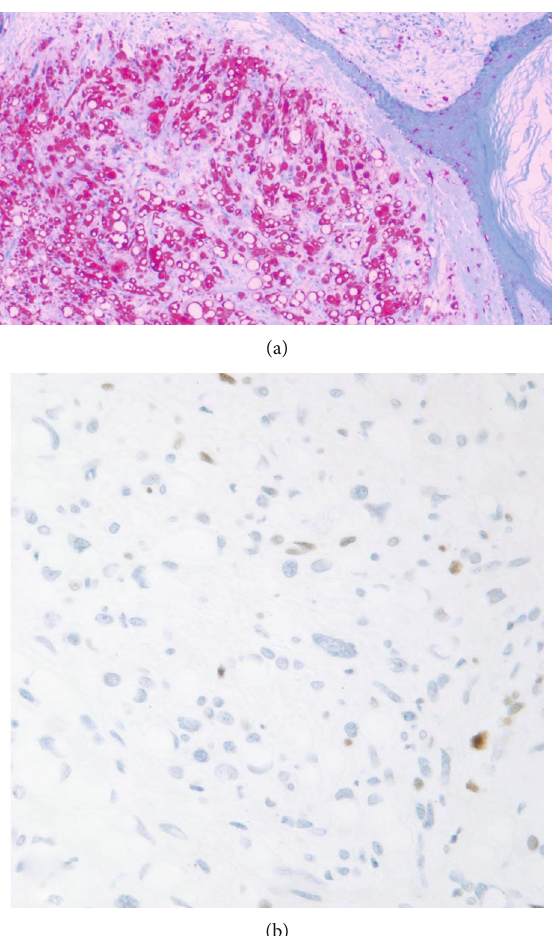
Figure 5: (a) S100 demonstrates prominent staining of univacuolar lipoblasts (100x). (b) Immunohistochemistry for Rb demonstrates absence of reactivity for Rb in the majority of tumor